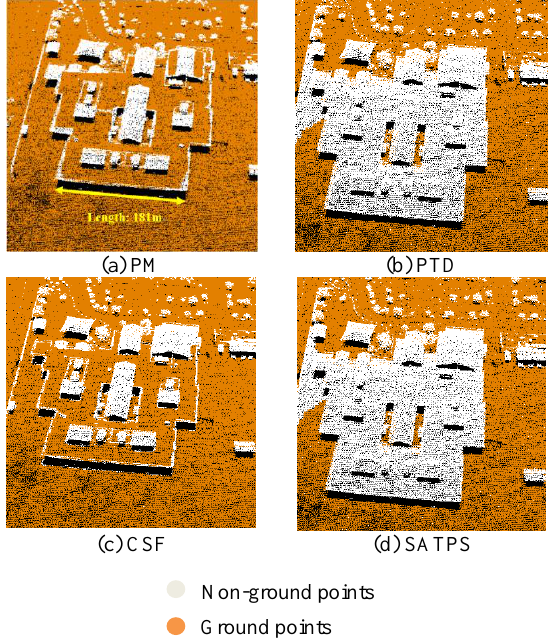
Figure 10. Comparative results of a building area in Area 10. As for the total error rate, the proposed SATPS algorithm achieves the best results in more than half of the areas. The total error rate increases sharply when dealing with